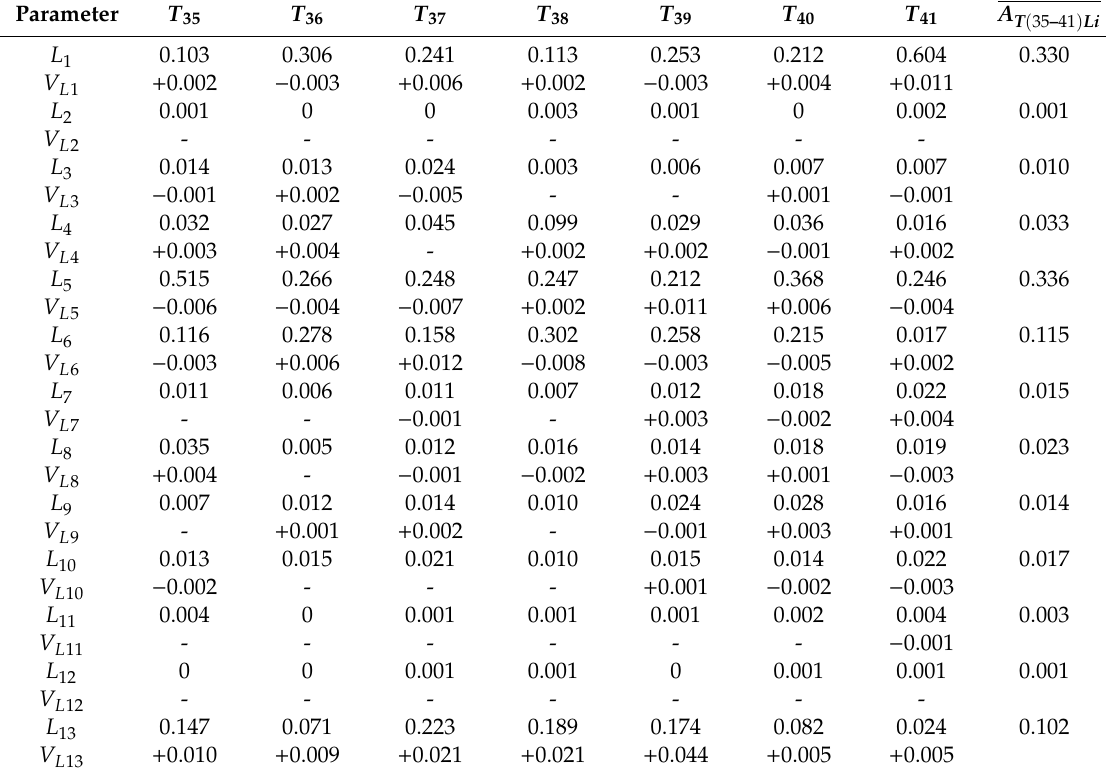
Table A12. Activity per land category in Russia, North Caucasian Federal District. Mean values for